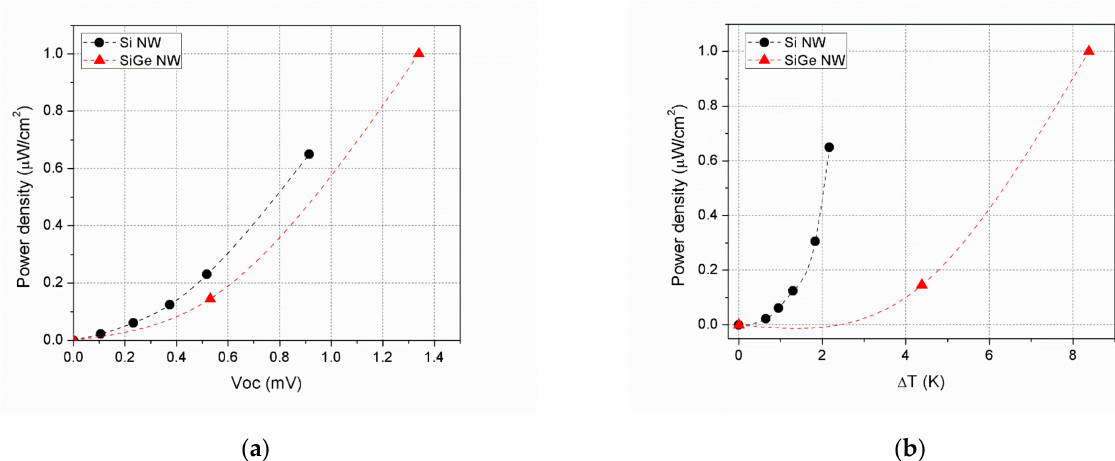
Figure 5. ( a ) Maximum power density obtained for Si and SiGe NW devices as a function of the open circuit voltage (showing the different device resistance at play); ( b ) internal ∆ T (showing the different electrical resistance and Seebeck coefficient at play). Notice that for clarity, only the data corresponding to the lower ∆ T portion available for SiGe has been